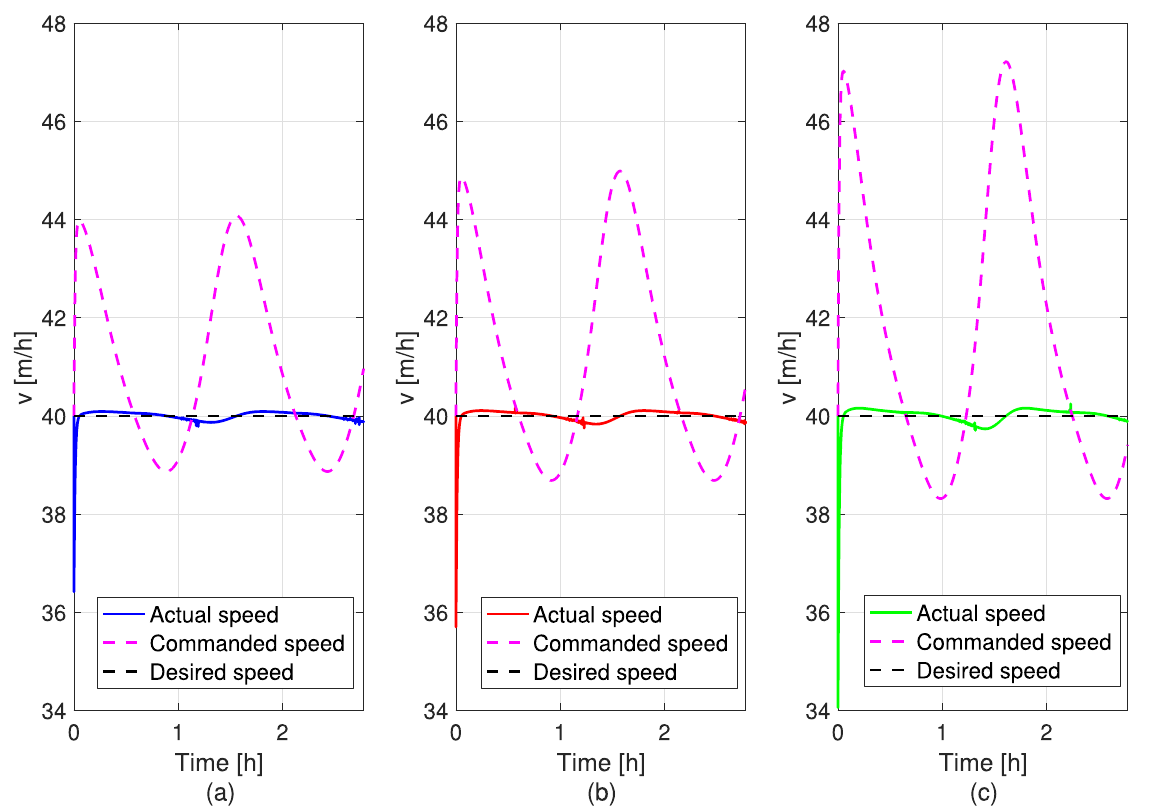
Figure 5. Rover’s speed on ( a ) cloddy soil, ( b ) mixed drift-cloddy soil and ( c ) drift soil on a 10° slope with constant steering angle 𝛿 = 4° .